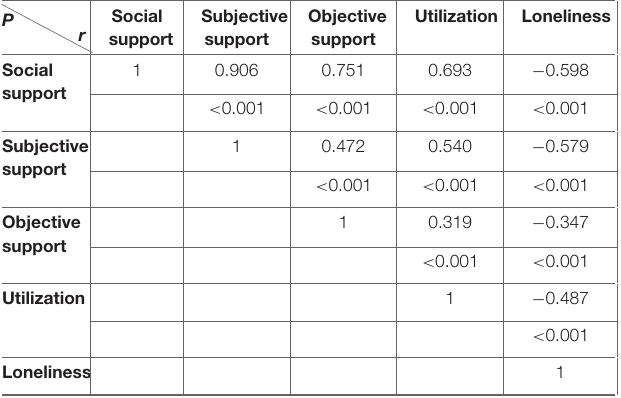
TABLE 3 | Pearson correlation analysis of social support and loneliness among caregivers of CKD children after PSM ( n = 202).